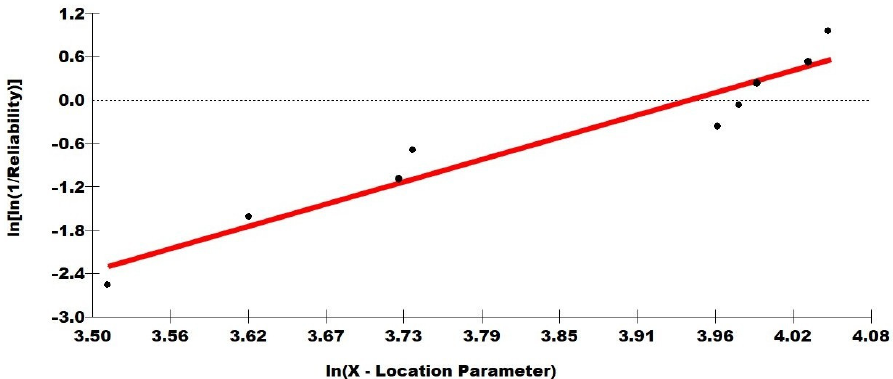
Figure 9. Weibull frequency distribution graph for the epoxy composites with 30 vol% of caranan